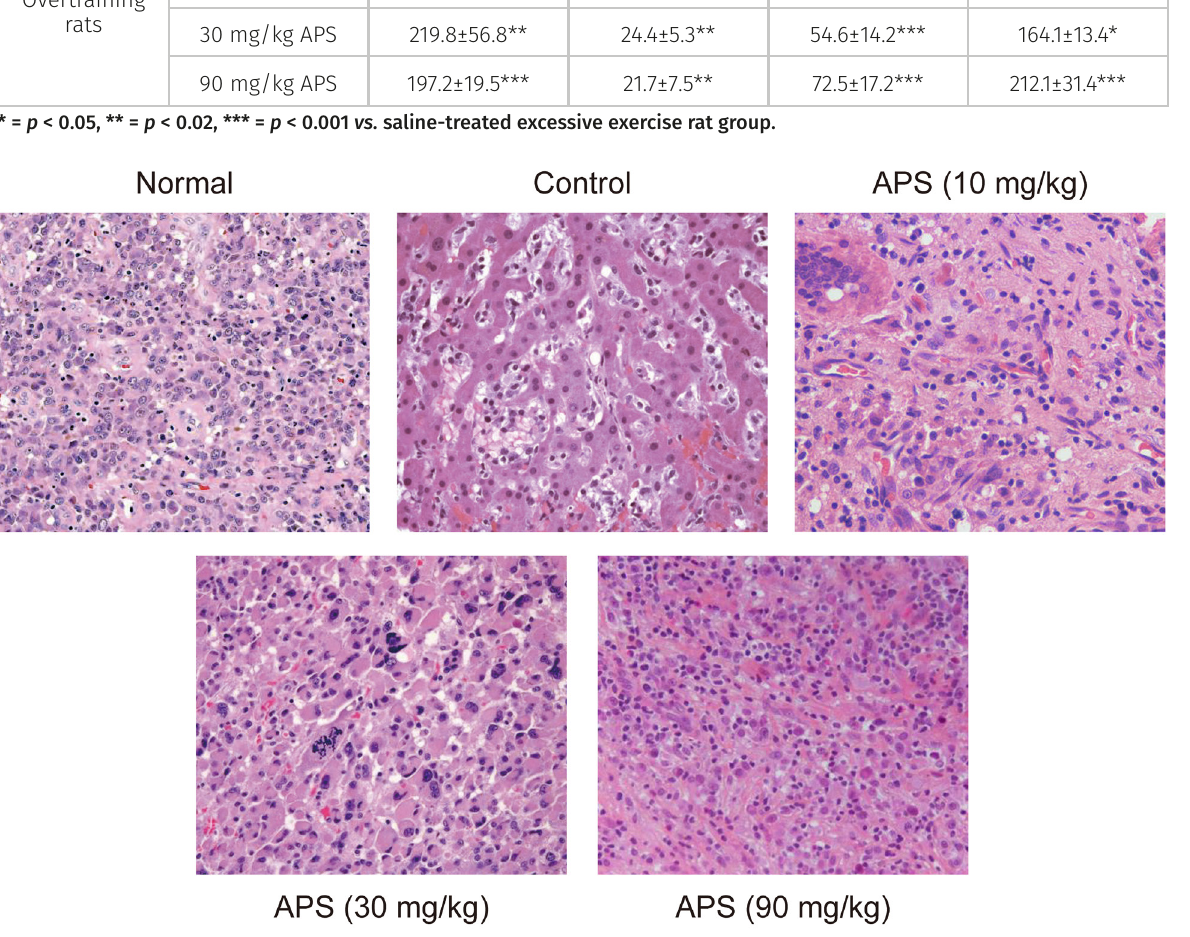
Figure 4. Cardioprotective efficacies of chronic treatment of APS at different doses on the cardiac injuries in excessive exercises-induced model